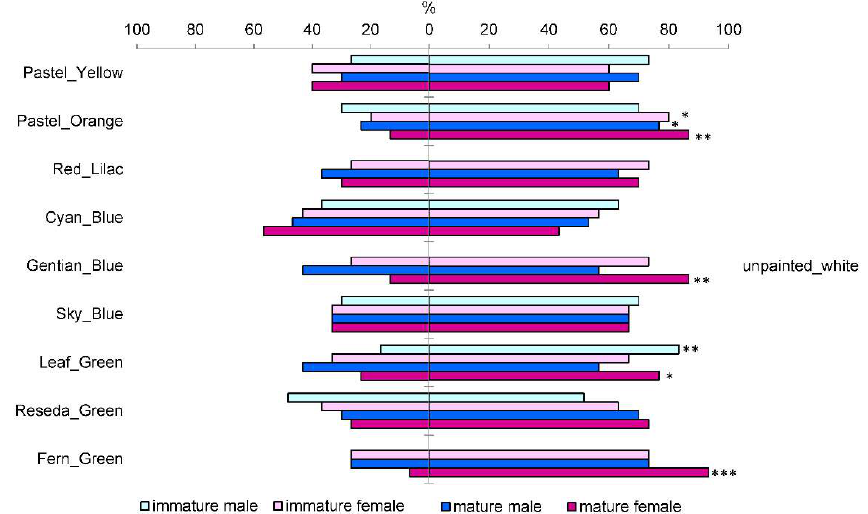
Figure 4. Percentage of immature and mature M. galloprovincialis beetles that responded to either the tested color or the unpainted white (coroplast) under laboratory conditions; *, **, *** indicate significant differences from the 50%:50% ratio with P < 0.05, P < 0.01, and P < 0.001, respectively (tested with the χ 2 test for 2 × 2 contingency tables using numbers of beetles provided in Supplementary Materials Table S1).